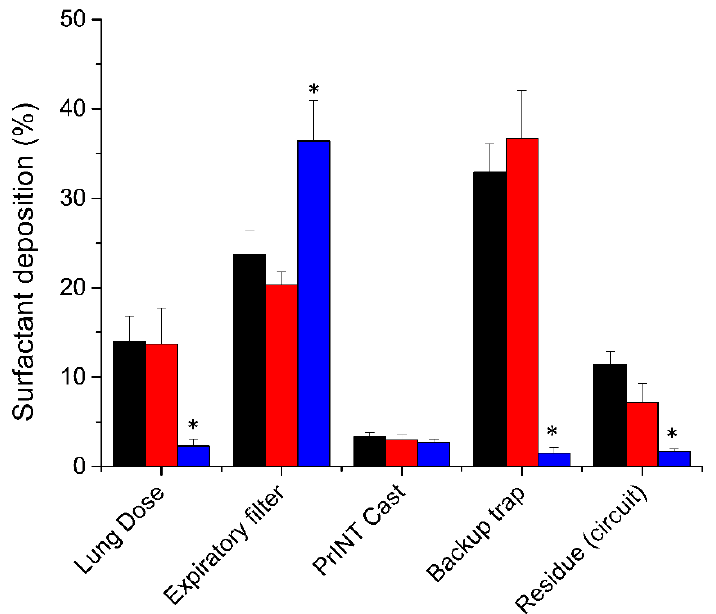
Figure 2. Mean cumulative percentage of deposited surfactant within different set-up compartments placing the nebulizer 7 cm away from the Y-piece (blue bars, n = 5) or between the Y piece and the continuous positive airway pressure (CPAP) interface (black bars for nasal mask and red bars for nasal prongs, n = 5). * P vs. nebulizer placed between the Y-piece and the CPAP interface < 0.01.